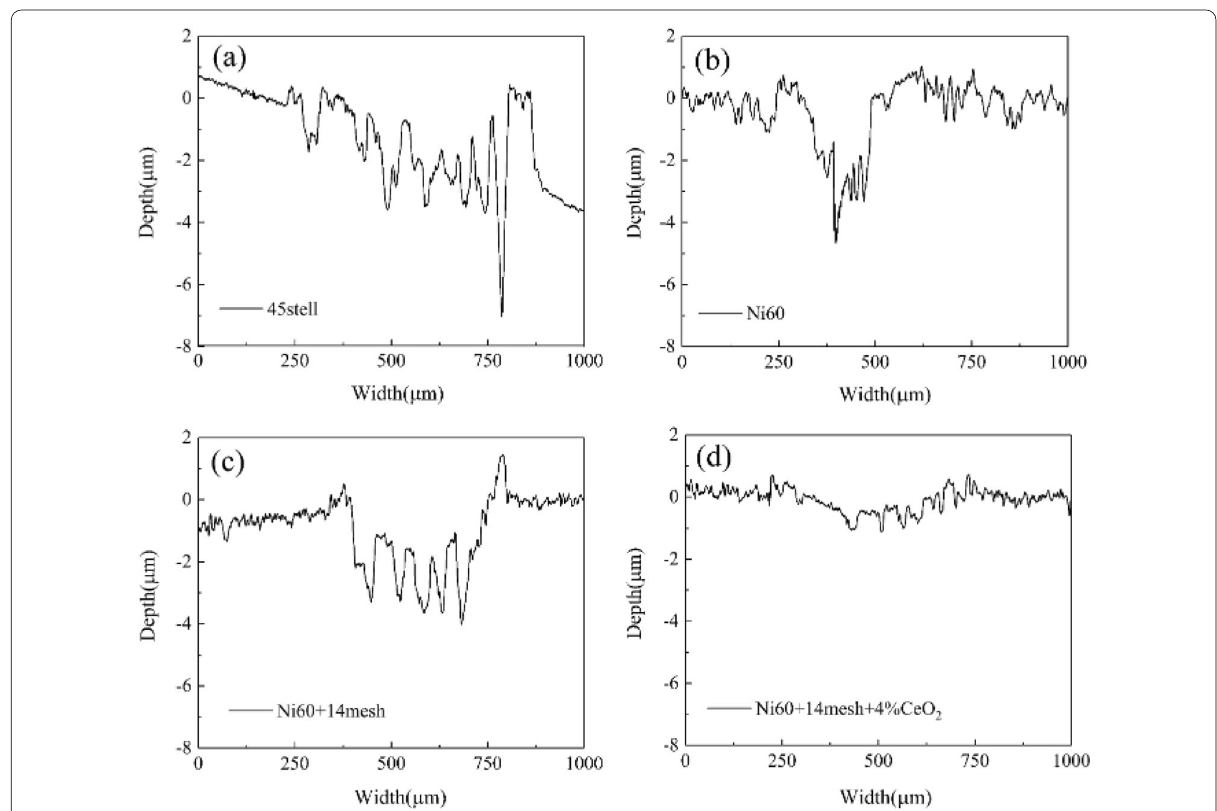
Figure 11 and Table 5 reveal the micro-morphologies and the constituent phases of the nickel-based composite